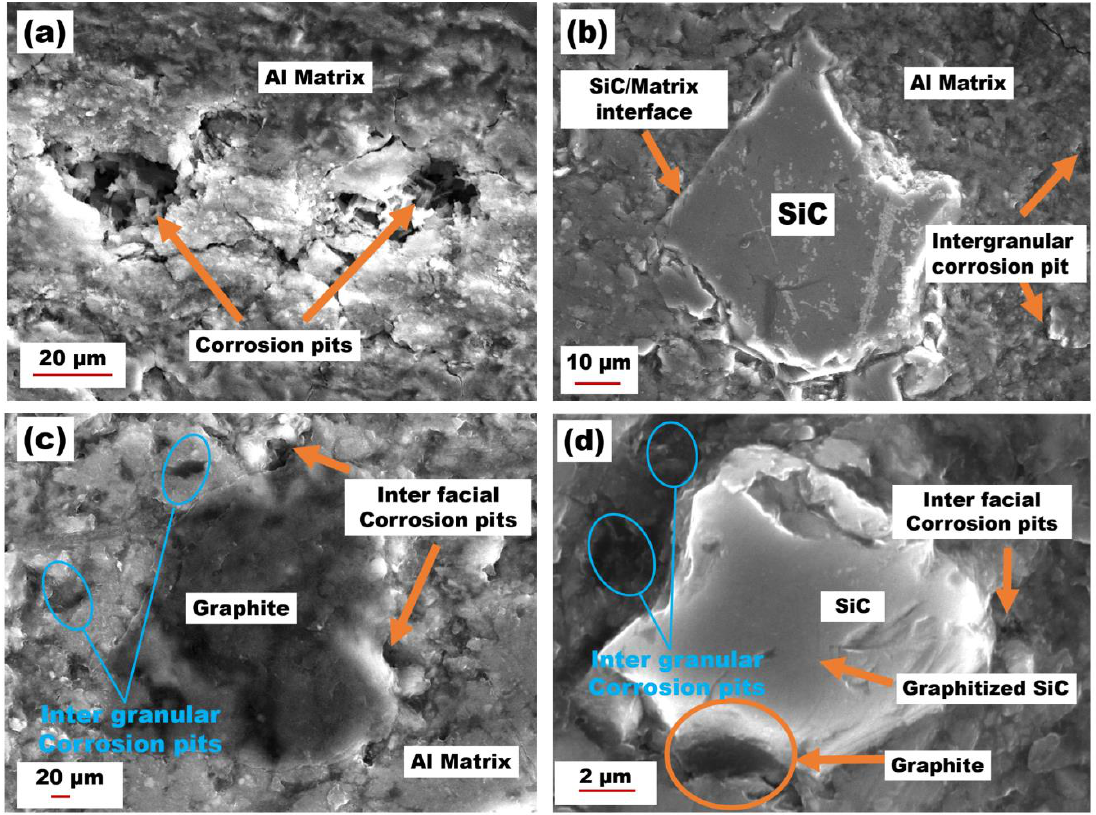
Figure 8. SEM micrographs of composite fabricated at 2200 rpm after potentiodynamic polarization test: ( a ) as-received Al, ( b ) Al-SiC mono composite, ( c ) Al-graphite mono composite, ( d ) Al-SiC-graphite hybrid composite.